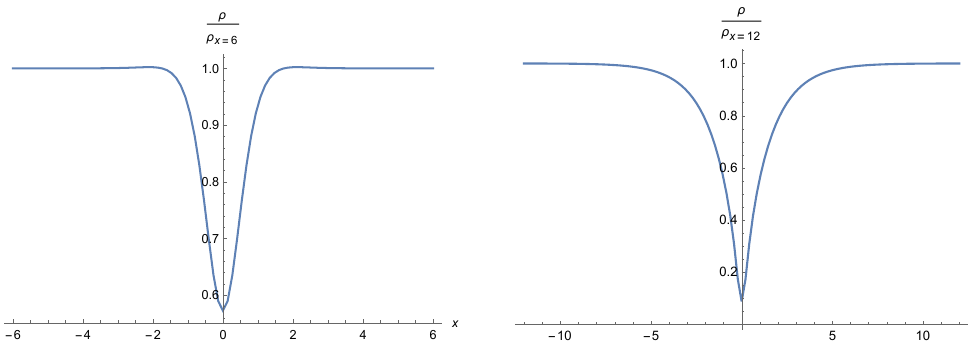
Figure 5 . The normalized density pro(cid:12)le ( (cid:22) = 5 : 5) for the standard quantization (left panel) and the alternative quantization (right panel). The values at the soliton cores are 0.572606 and 0.0866772 for the standard and alternative quantizations, respectively.